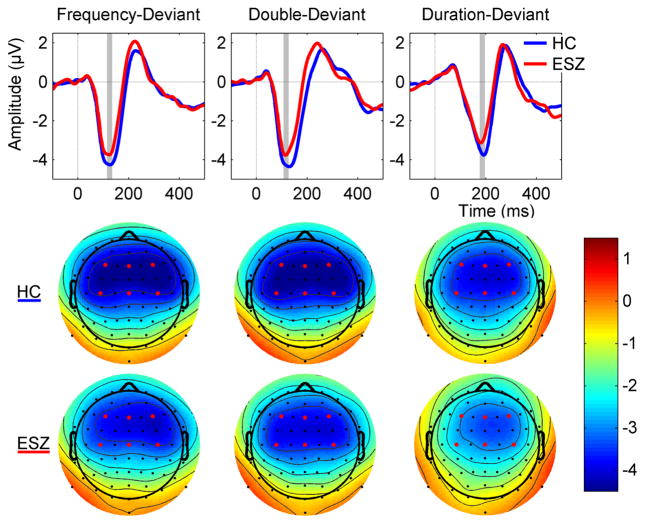
Mismatch Negativity (MMN) Amplitude For Each Group And Deviant Type. Ear-referenced ERP difference waveforms averaged across electrodes Fz, Fz, F4, C3, Cz, C4 for Duration, Double (duration + frequency), and Frequency MMN are given for each group (top). Healthy Controls (HC) are shown in blue, and individuals with Early Illness Schizophrenia (ESZ) in red. Scalp voltage topography maps of MMN amplitudes are shown for HC (middle) and ESZ (bottom) for each deviant type. MMN topography maps show the group means of MMN amplitudes around the grand average peak latency ±10 ms (indicated by gray bars in ERP difference waveform plots). Red dots on scalp topography maps indicate the 6 channels used in group comparisons and plotted in grand average waveforms. MMN is reduced in ESZ relative to HC across deviant types. Plotted data reflect group averages prior to any standardization based on the HC group